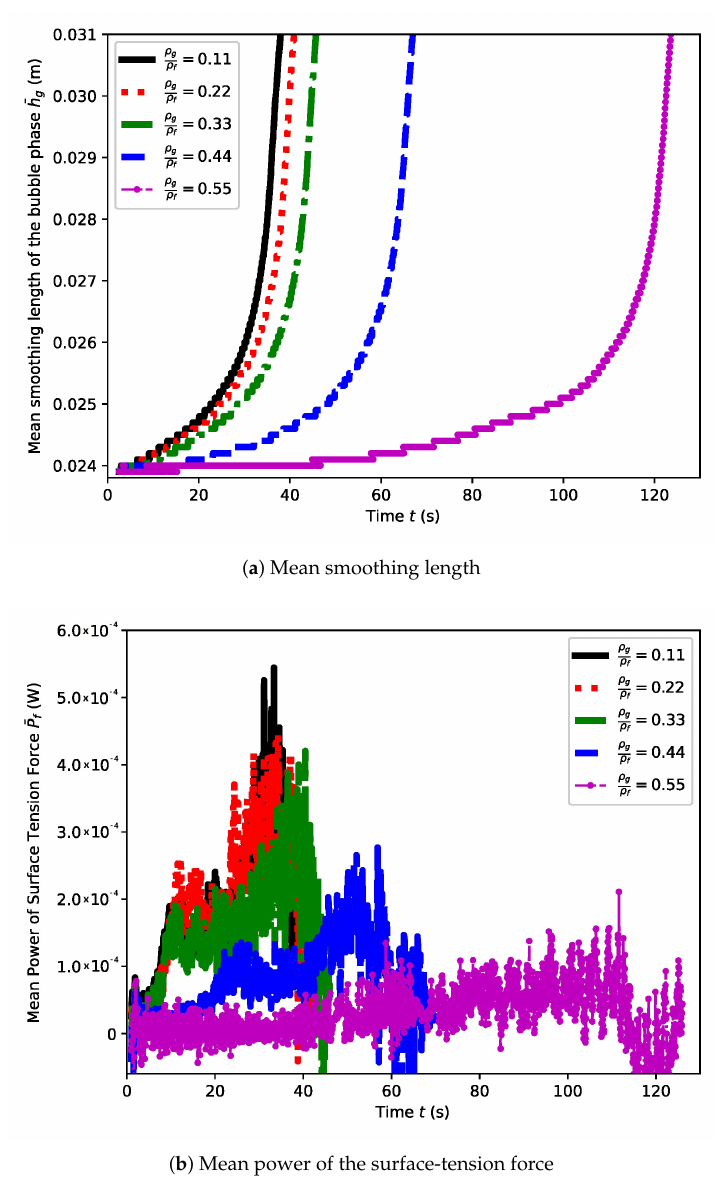
Figure 10. The mean smoothing length ¯ h ( a ) and the mean power ¯ P f ( b ) of the bubble case for different density